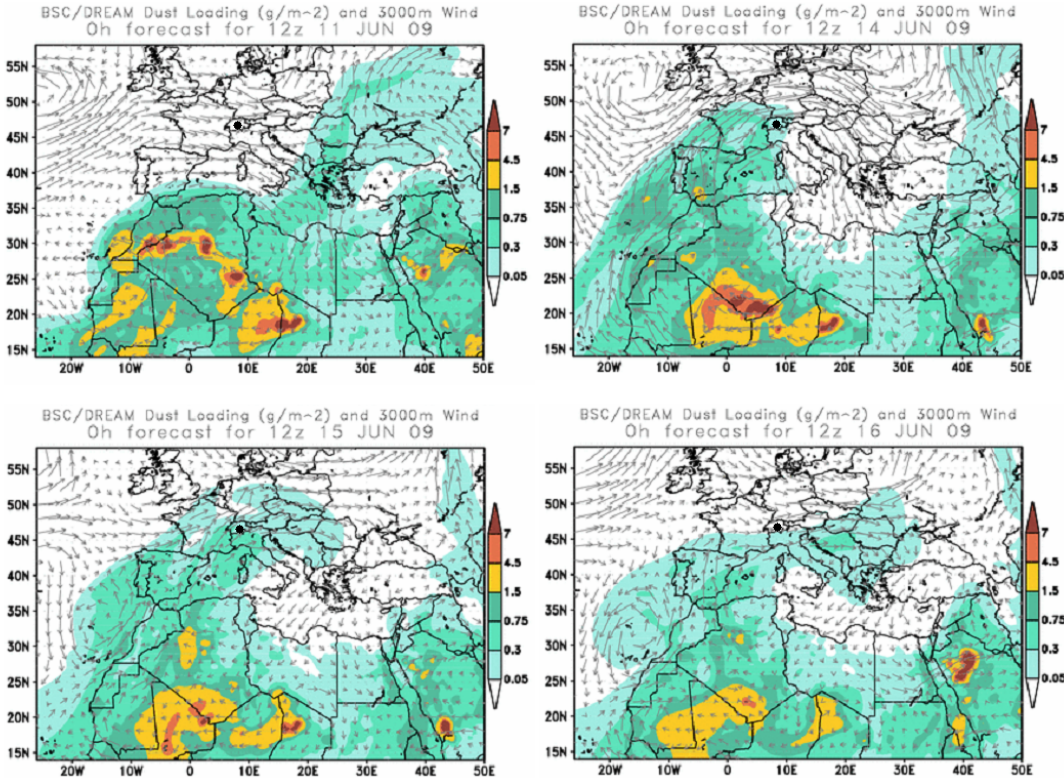
Fig. 9. Dust load distribution over the Mediterranean region on June 11 th , 14 th , 15 th and 16 th , 2009 at 12.00 pm UTC. The black dot marks the location of the Jungfraujoch.